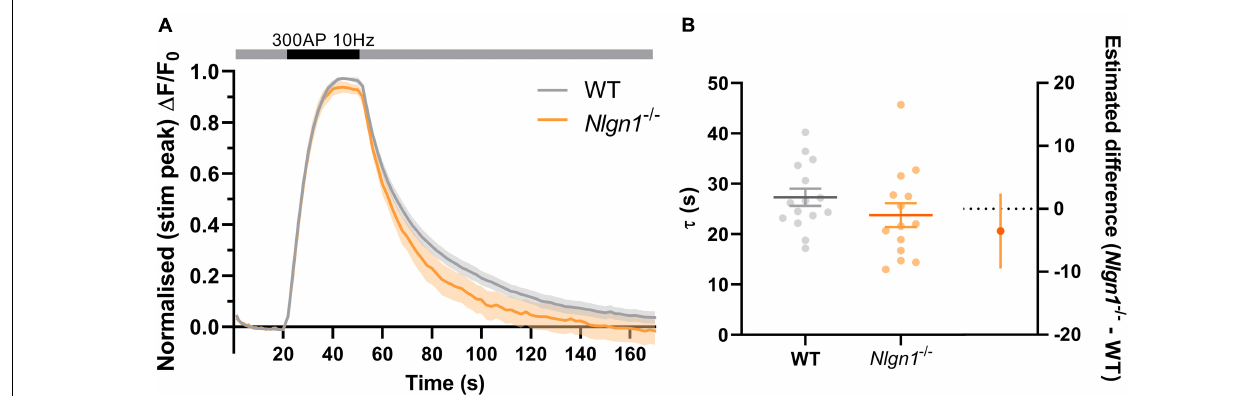
FIGURE 4 | Loss of Nlgn1 − / − does not impact post-stimulus compensatory endocytosis. Nlgn1 − / − and WT neurons transfected with sypHy were stimulated with 300 action potentials at 10 Hz, and change in fluorescence monitored over time. (A) Time trace of mean ( ± SEM) changes in sypHy fluorescence, normalised to peak fluorescence during stimulus train. Mixed model ANOVA with Sidak’s multiple comparison test, p > 0.05 across all time points. (B) Mean ( ± SEM) endocytic decay time constant (tau, s) from single exponential decay curve fit to data following end of stimulus train (from Figure 2A ). Scatter plots show individual n (single coverslip average), bars indicate mean ± SEM. Forest plot shows estimated difference between group means with 95% CI, unpaired t -test, p = 0.2332. N = 14–15 individual fields of view from independent coverslips, as in Figure 2